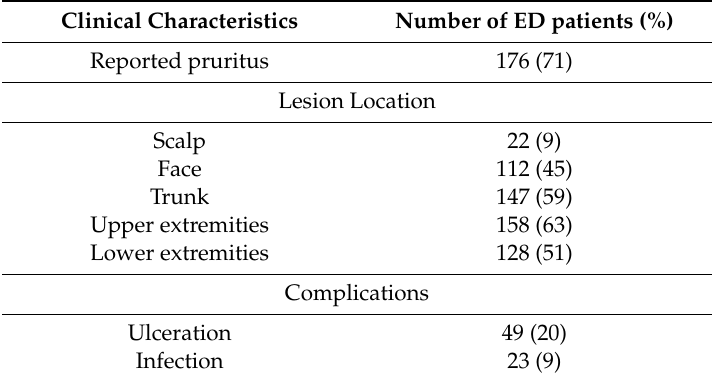
Table 3. Clinical features of